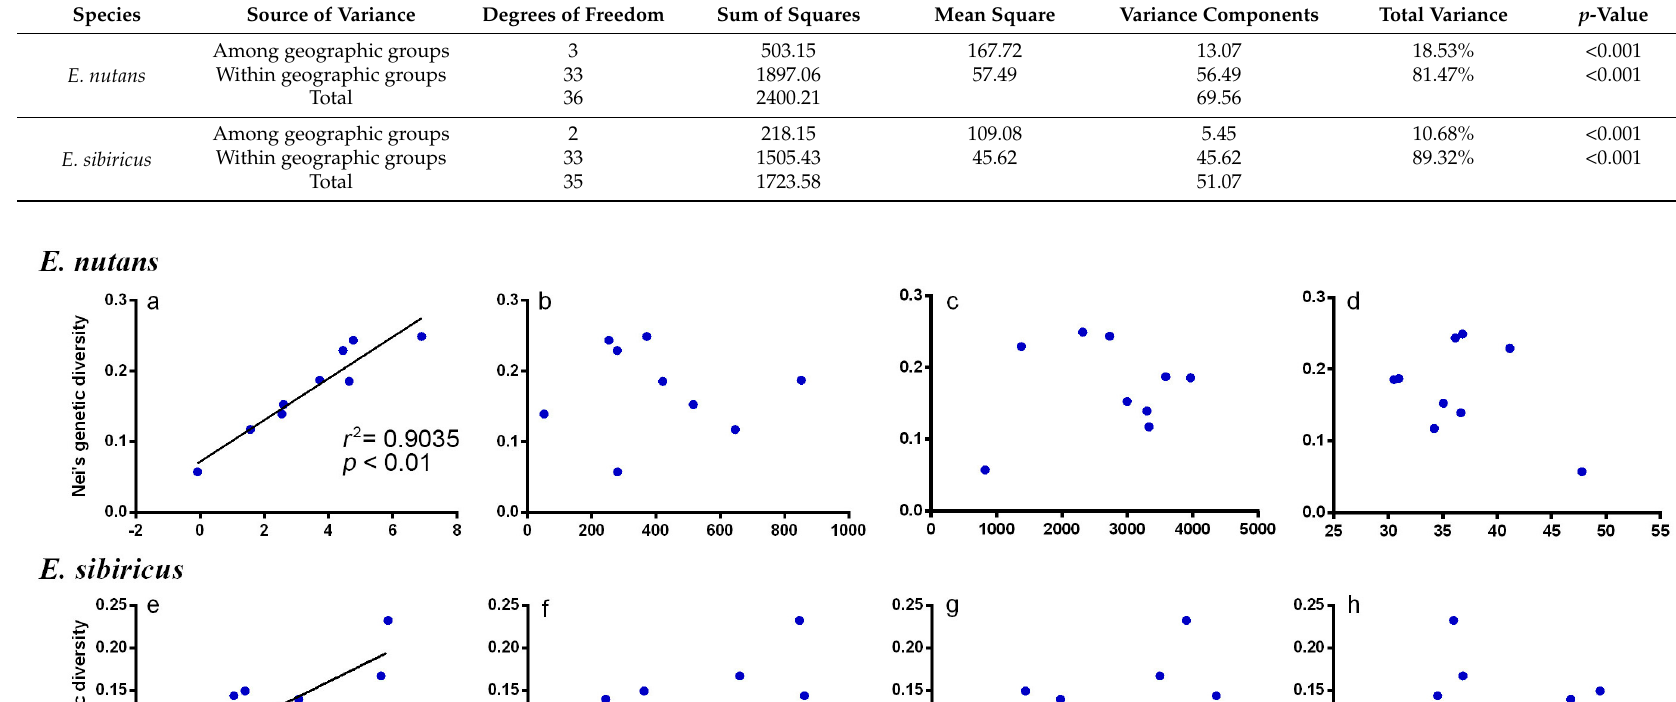
Table 5. Analysis of molecular variance (AMOVA) of in four E. nutans and three E. sibiricus geographic groups.